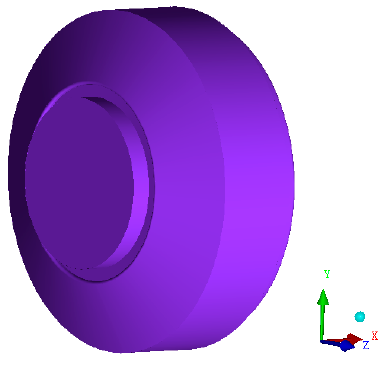
Figure 7. Chamber of the centrifugal pump.